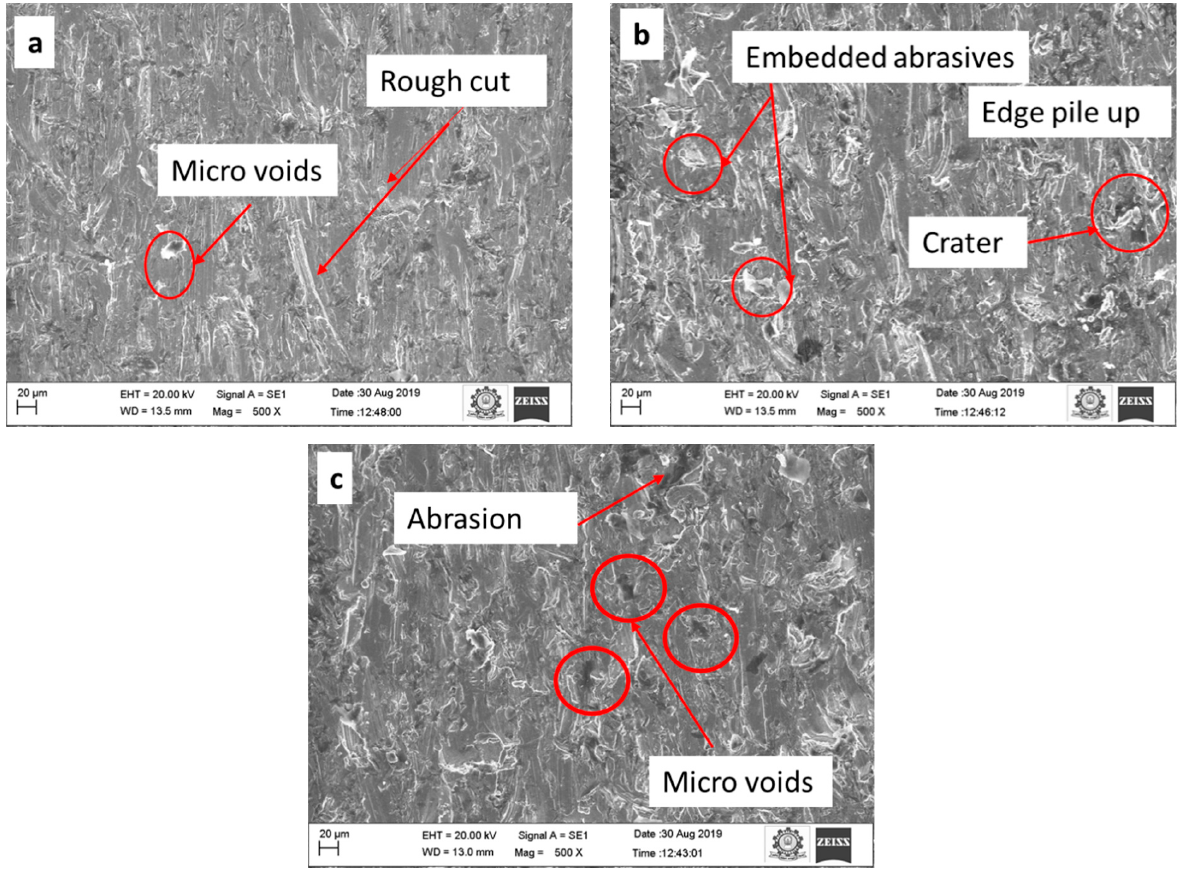
Figure 7. AWJM surface micrograph at SOD = 2 mm, JT = 15 mm/min, and P = 260 MPa ( a ) top, ( b ) middle, and ( c ) bottom region.